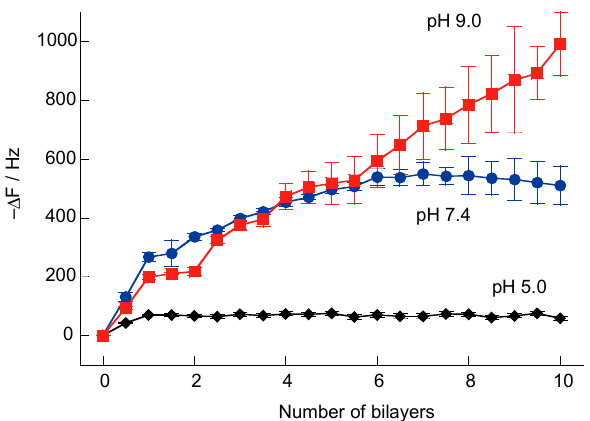
Figure 4. QCM resonator frequency changes during the preparation of (SA-PAH/PBA-PAH) n films in a 10 mM CHES buffer (pH 9.0) in the presence and absence of NaCl (150 mM or 1 M). Polymers 2018 , 10 , x FOR PEER REVIEW